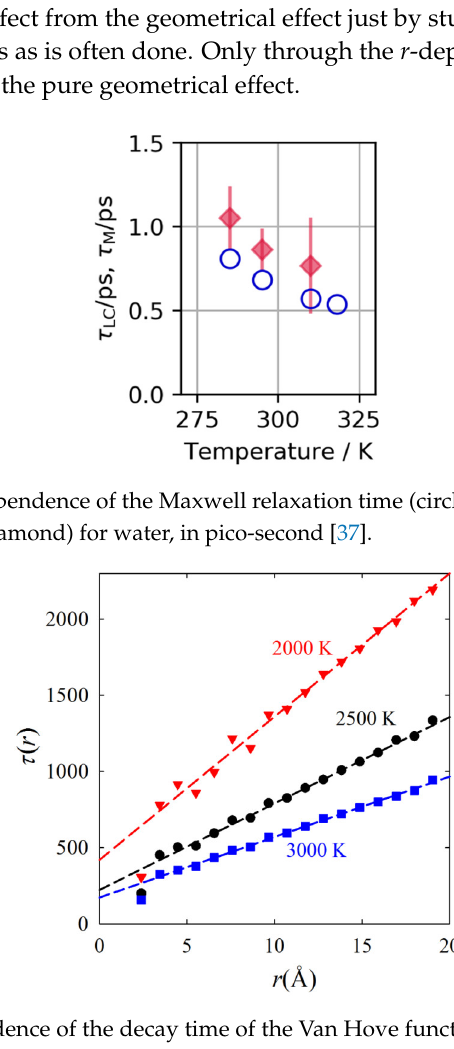
Figure 9. Distance dependence of the decay time of the Van Hove function at various temperatures, simulated for liquid Fe in the unit of femto-second [44]. simulated for liquid Fe in the unit of femto-second